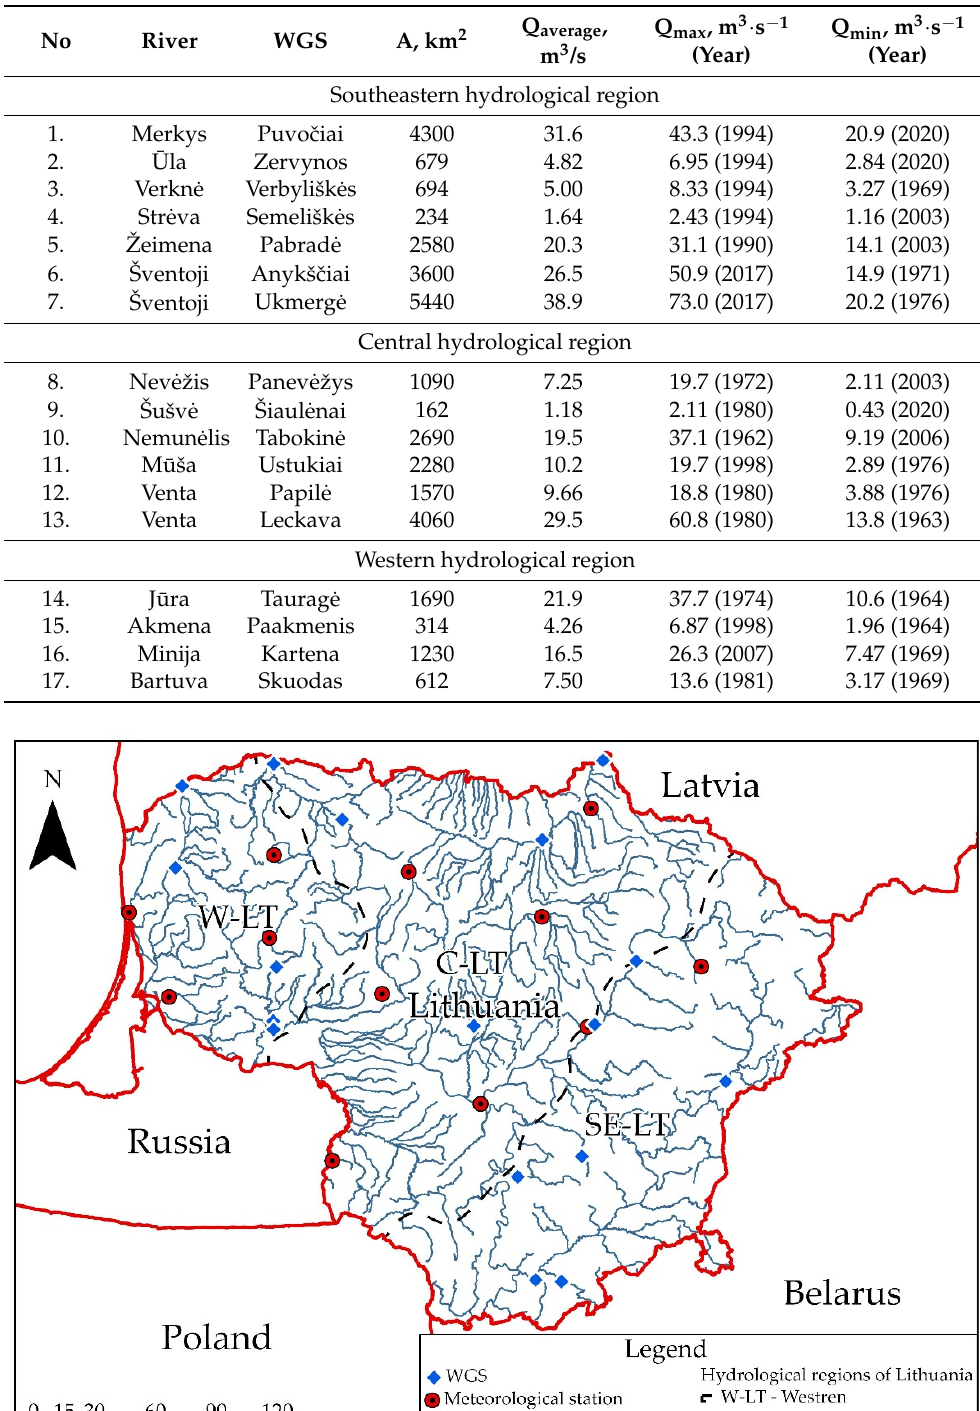
Table 1. List of the studied gauging station catchments with the main characteristics (observation period 1961–2020).